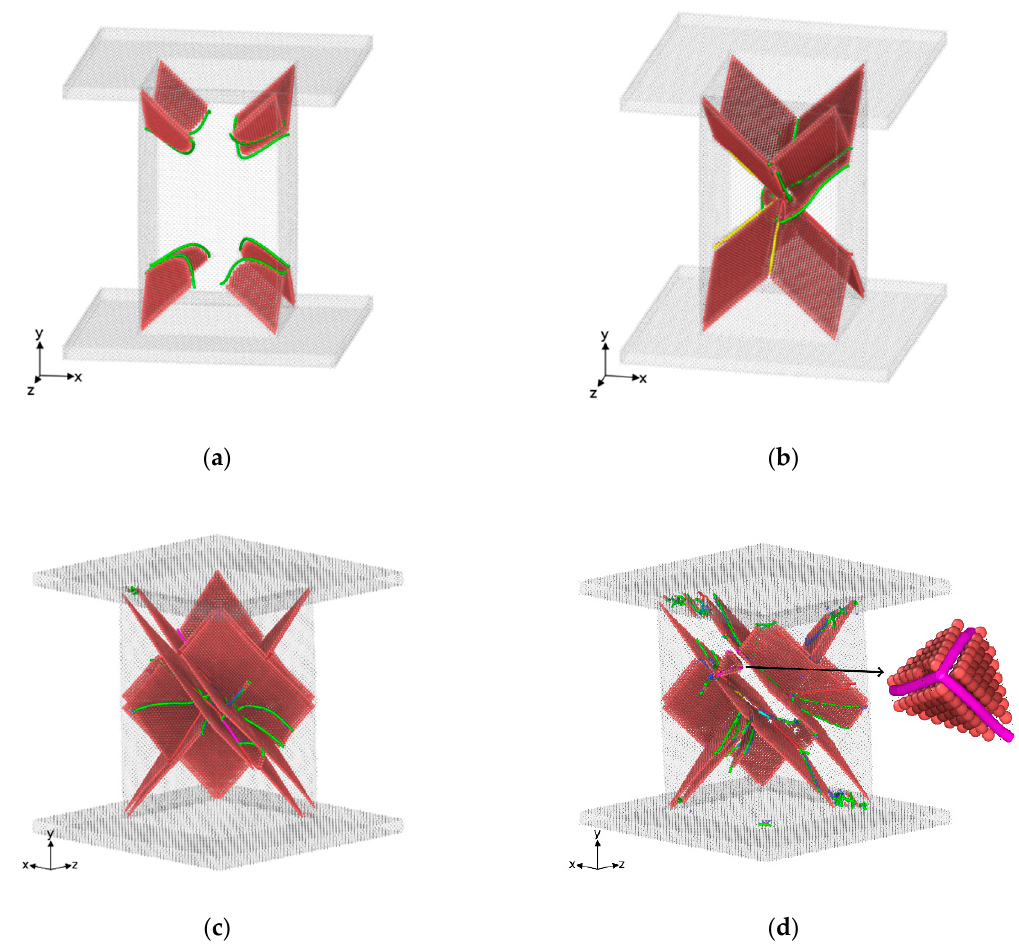
Figure 12. Surface deformation patterns in a simulated < 001 > single crystal with h / d = 2 and {100} lateral faces at a sequentially increasing strain of ( a ) 7.92%; ( b ) 7.95%; ( c ) 9.32% and ( d )